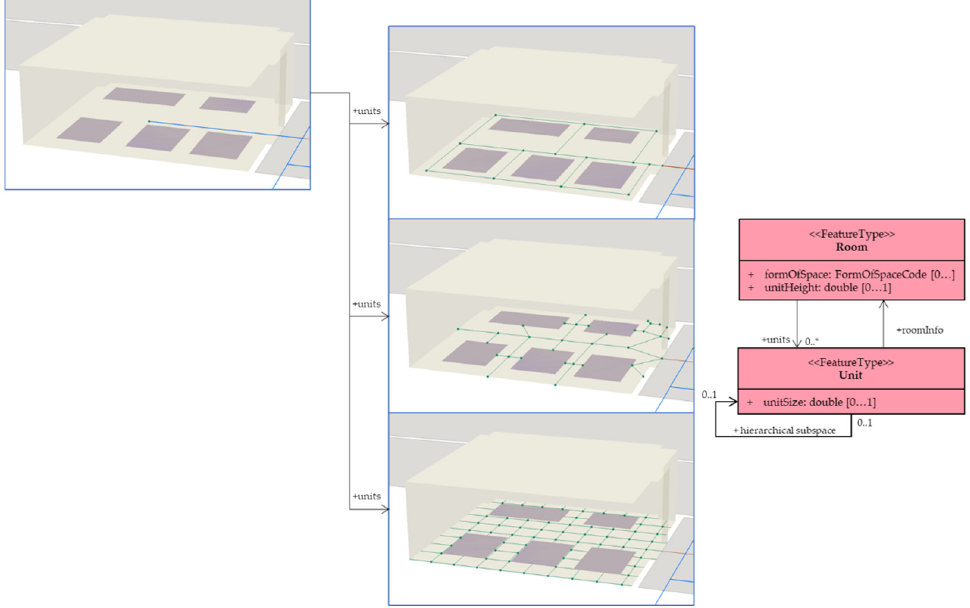
Figure 20. Self-association relationship of the Unit class to reflect different types of networks for the same Unit space.